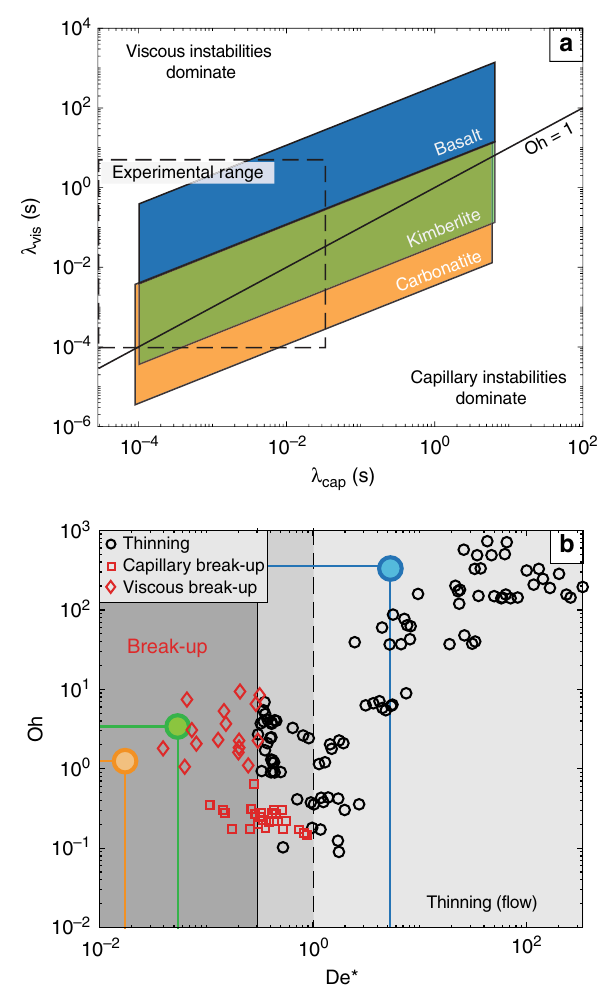
Fig. 4 The break-up characteristics of natural volcanic melts under extension. a Predicted viscous and capillary timescales for volcanic pyroclasts. The shaded fi elds denote the range of Ohnesorge number expected for the eruption of basalt (blue), kimberlite (green) and carbonatite (orange). Note that the carbonatite fi eld extends underneath the kimberlite fi eld. A line of Oh = λ vis / λ cap = 1 separates where capillary (Oh <1) or viscous (Oh >1) instabilities dominate. b Break-up vs. fl ow behaviour map that relates the intrinsic properties of the melt (Ohnesorge number; Oh) to the eruption conditions (modi fi ed Deborah number; De*). Shading from light, intermediate to dark grey indicates zones of solely thinning, both thinning and break-up and solely break-up, respectively. Lines show example calculation results for basalt (blue), kimberlite (green) and carbonatite (orange) NATURE COMMUNICATIONS| (2019) 10:3828